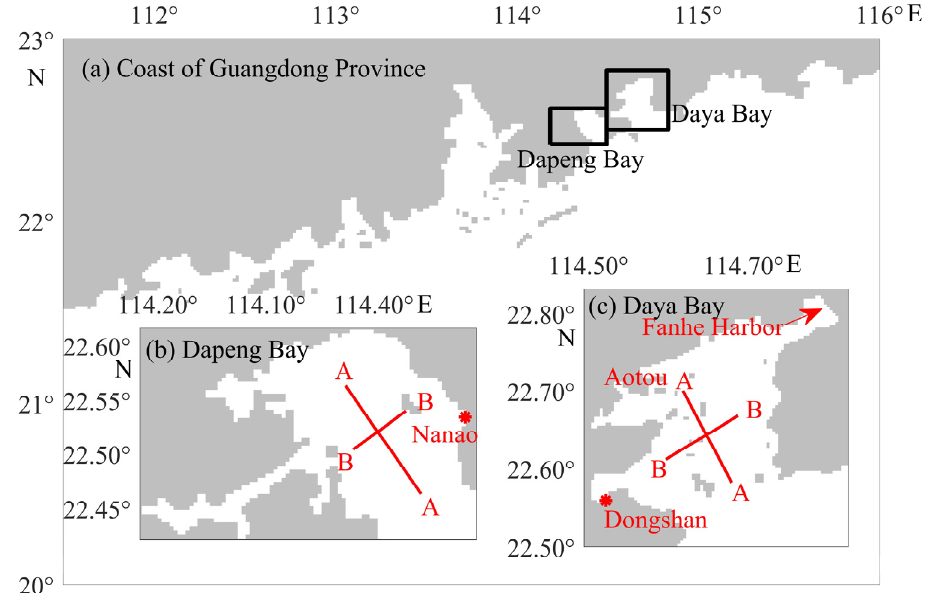
Figure 1. ( a ) Coastline of Guangdong Province of China, ( b ) Dapeng Bay and ( c ) Daya Bay off Shenzhen City and positions of Nanao and Dongshan stations. The A–A direction is the along-bay direction, and the B–B direction is the cross-bay direction.